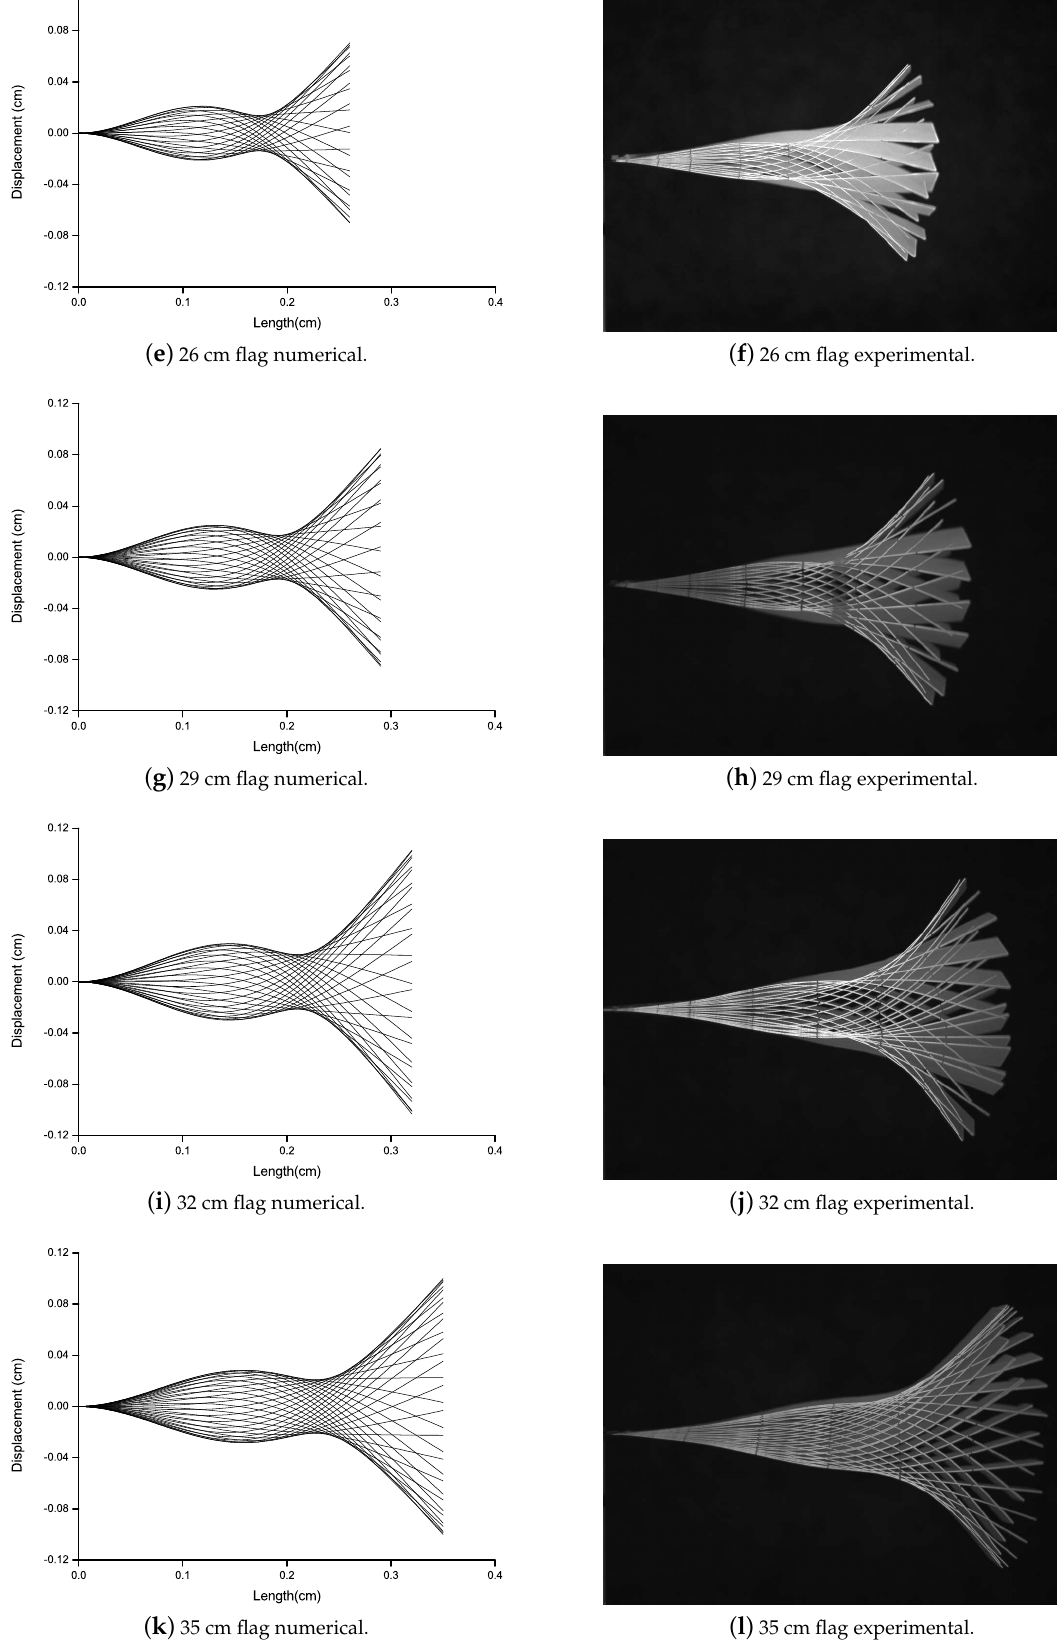
( l ) 35 cm flag experimental.